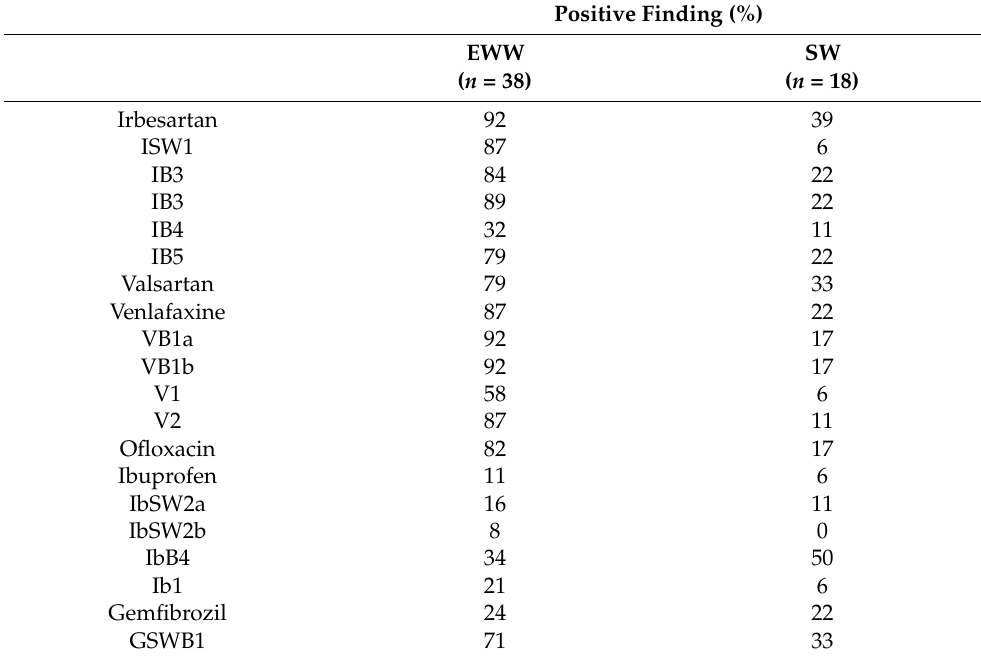
Table 1. Pharmaceuticals and metabolites/TPs detected in Effulent waste water and surface wa- ter samples after retrospective search in Q-TOF- MS data. (Reprinted from [46]. (Copyright 2016,